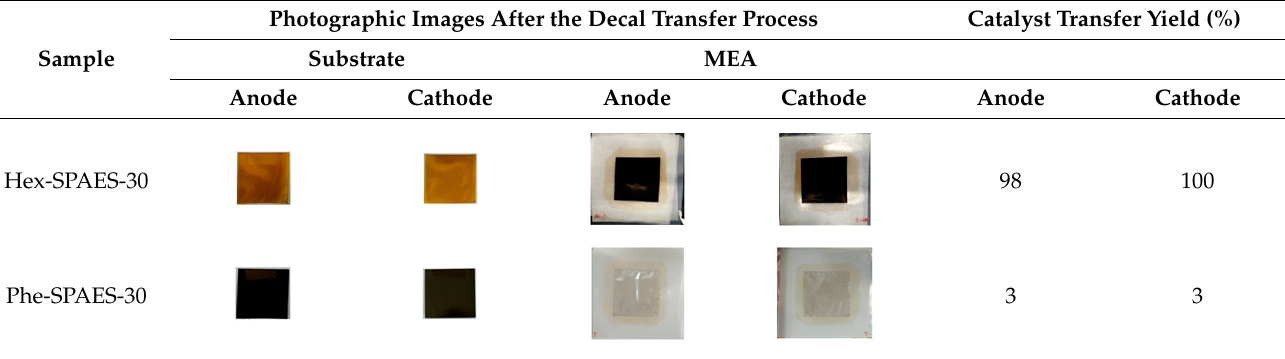
Table 4. Photographic images of the membrane electrode assemblies after the decal transfer process, and catalyst transfer yields achieved using the Hex-SPAES-30 and Phe-SPAES-30 membranes.